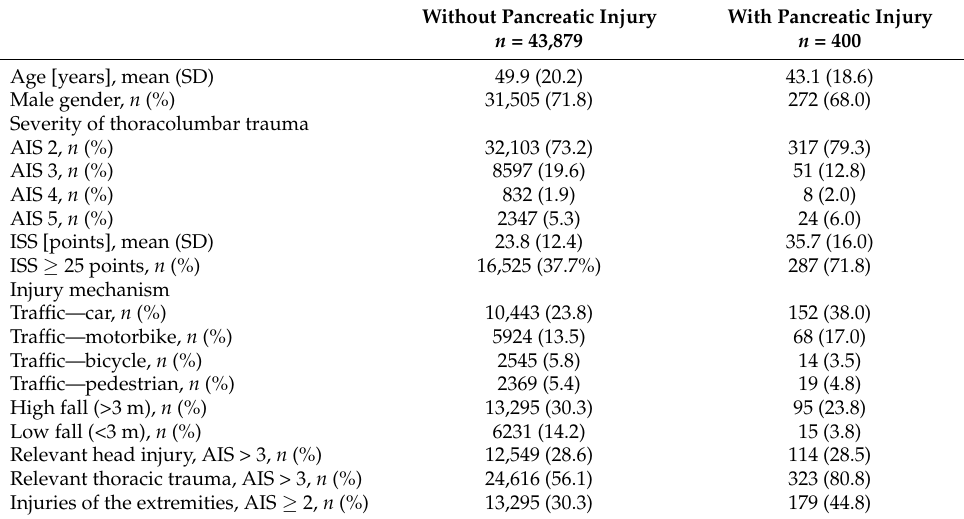
Table 1. Demographic- and trauma-related